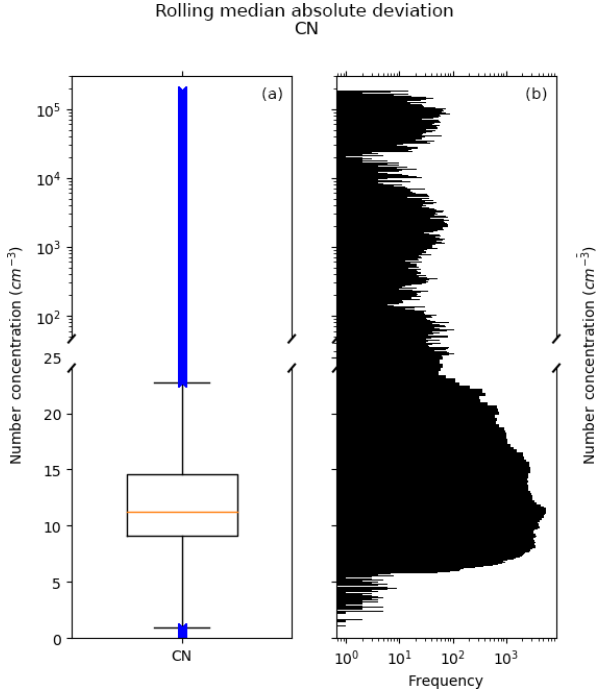
Figure A6. Distribution of the MADs calculated from rolling through CN number concentrations. (a) Box-and-whisker plot with quartiles drawn. Whiskers represent the quartiles ± 1 . 5 times the in- terquartile range. (b) Histogram. Note the split axis, which changes from linear to logarithmic scaling.